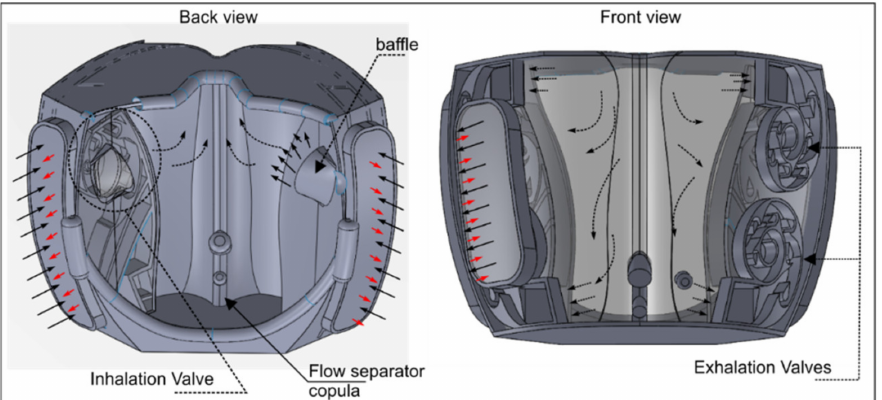
Figure 2. Interior view of the mask. The back view shows the valves and baffles for inhalation events, and the front view shows the valves for exhalation